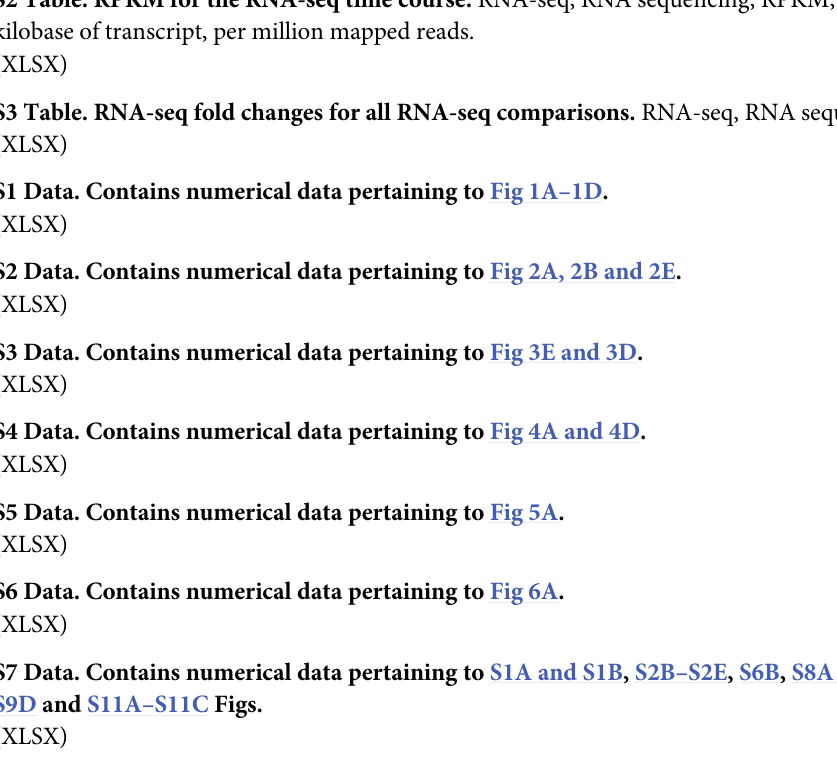
S1 Table. FAIRE RPKM for high-confidence peaks in the wild-type time course and trans- genic lines. FAIRE, formaldehyde-assisted isolation of regulatory elements; RPKM, reads per kilobase of transcript, per million mapped reads. S2 Table. RPKM for the RNA-seq time course. RNA-seq, RNA sequencing; RPKM, reads per kilobase of transcript, per million mapped reads. S3 Table. RNA-seq fold changes for all RNA-seq comparisons. RNA-seq, RNA